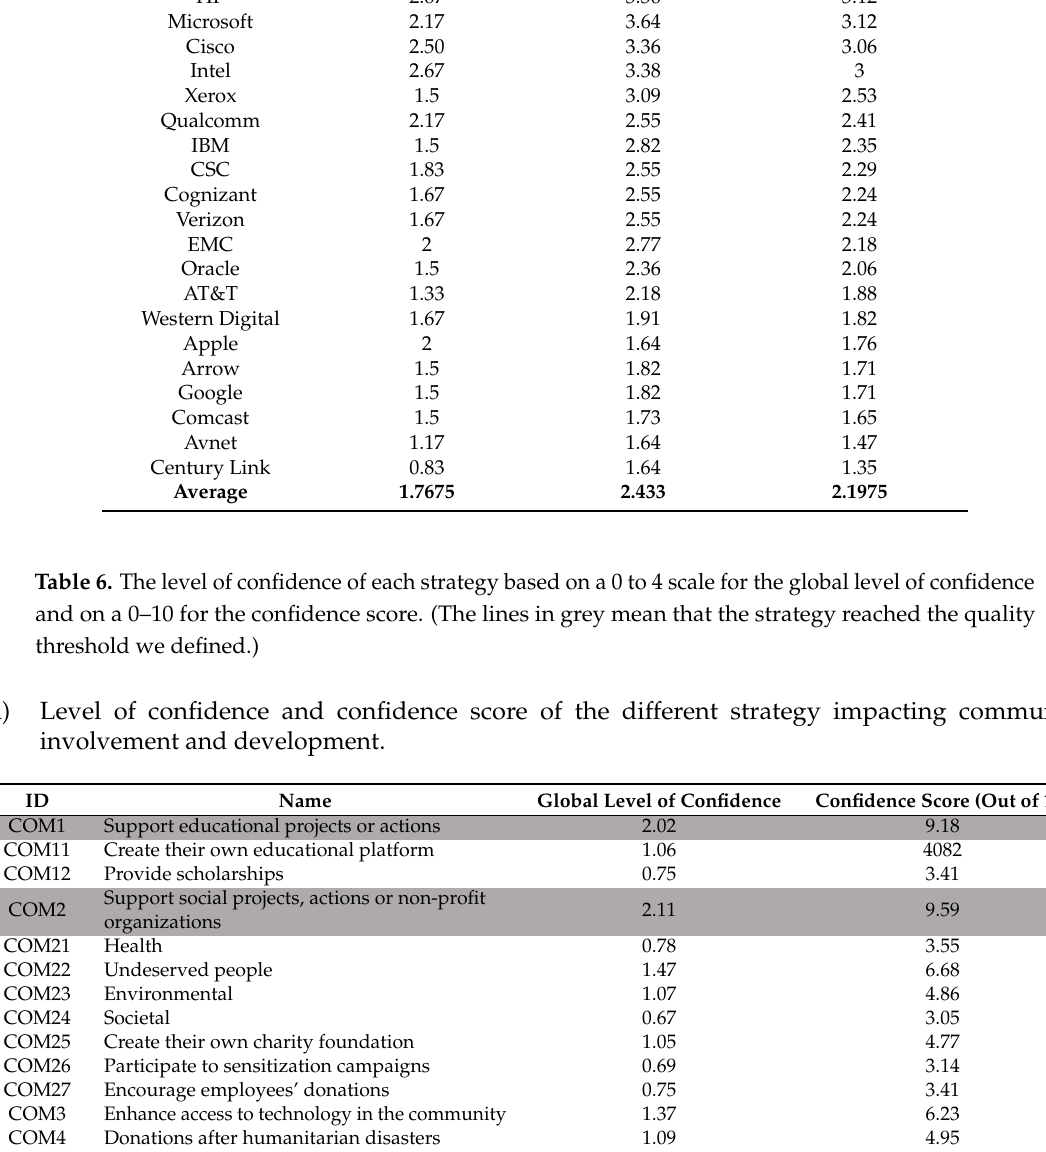
Table 5. Quality score of the reports from the highest to the lowest and all the different quality criteria.